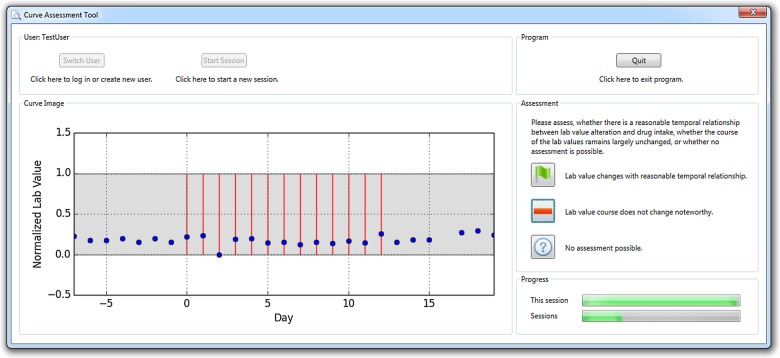
Screenshot of the software tool used for the assessment of the data.